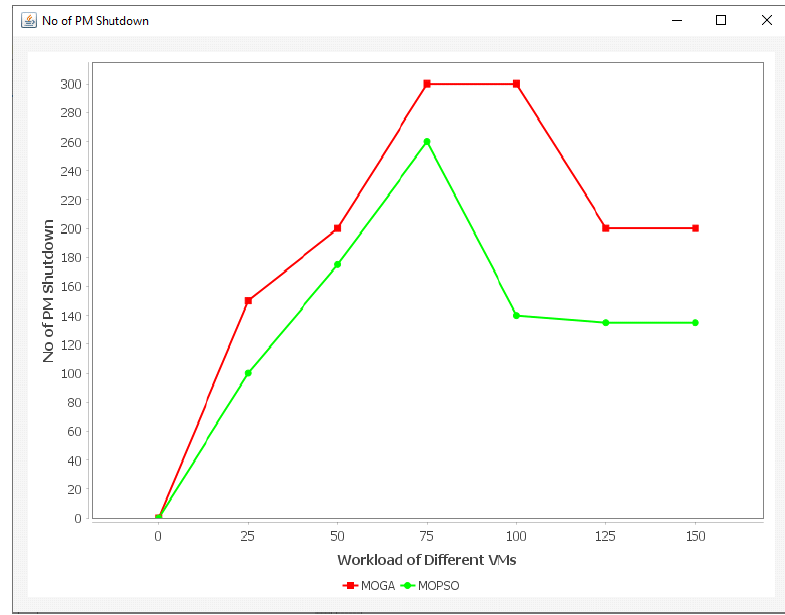
Figure 7. Physical machine shutdown. Table 5. PM shutdown with VMs for MOGA and MOPSO.